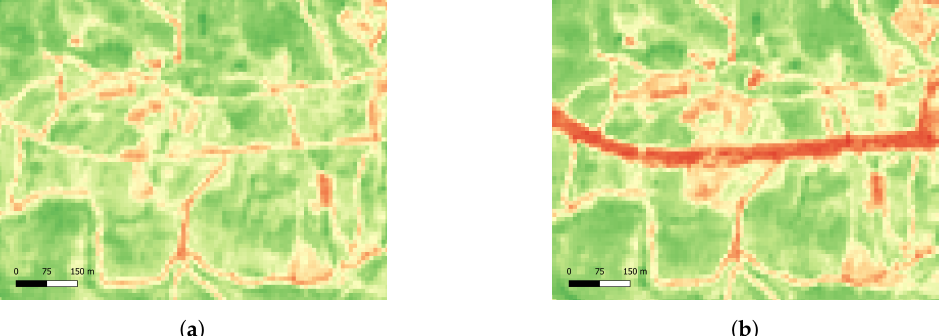
Figure 15. NDVI before and after the intervention for Site A. ( a ) NDVI on 15 May 2018. ( b ) NDVI on 19 June 2018.